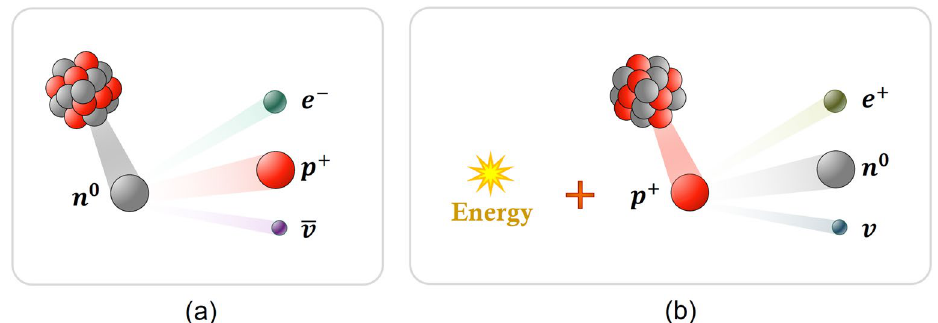
Figure 3. Processes of β -decay: ( a ) β − -decays, and ( b ) β + -decays.